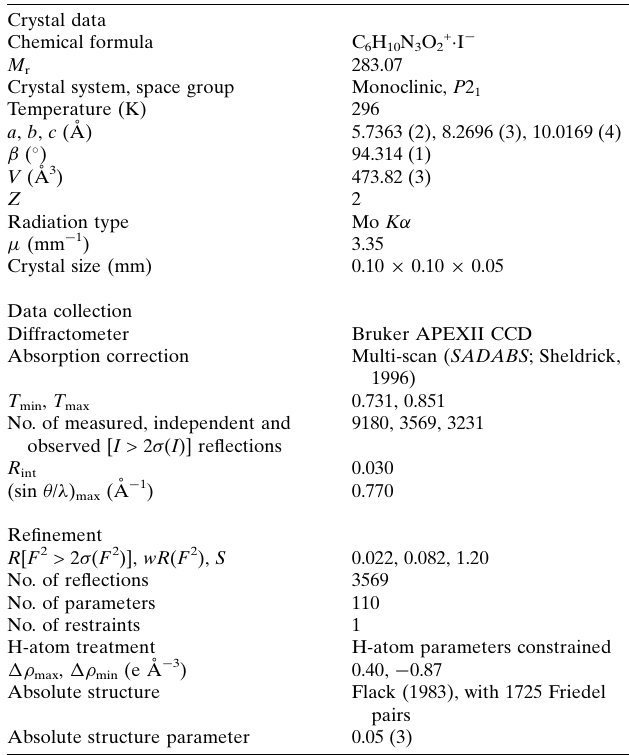
Table 2 Experimental details.